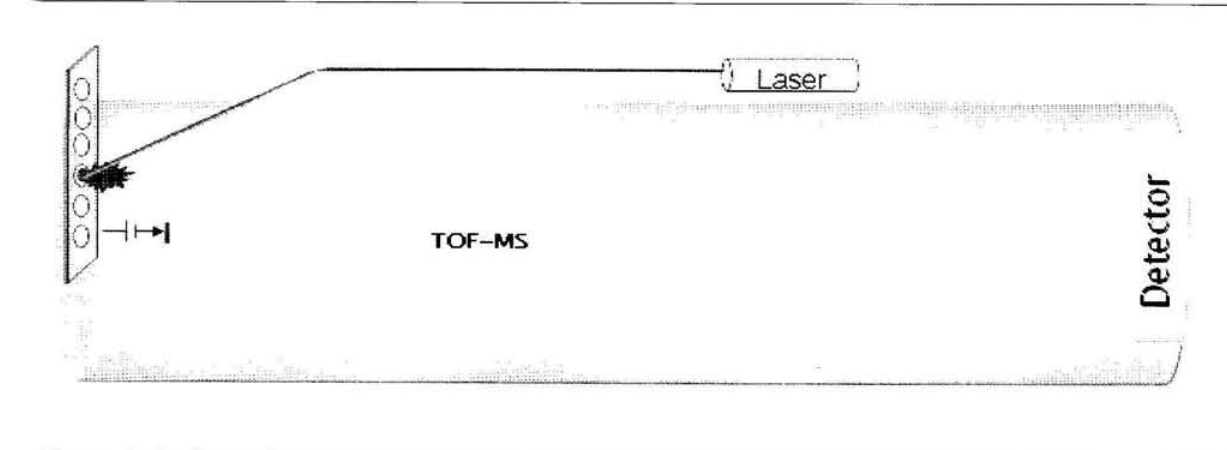
Figure /. Surface enhanced laser desorption ionisation-time of flight (SELDI-TOF). The proteins are "eluted" from the matrix array by laser desorption and ionization. The ionized proteins are detected and their mass accu- rately determined by Time-of-Flight Mass Spectrometry. Details are described elsewhere. In brief the molecules arc liberated from the matrix and carried to the detec- tor. Specific proteins can be identified by the charac- teristic peaks of the spectrogram. The proteins are applied on the surface of a (SELDI)-matrix. Then the matrix is inserted into the vacuum chamber of the mass